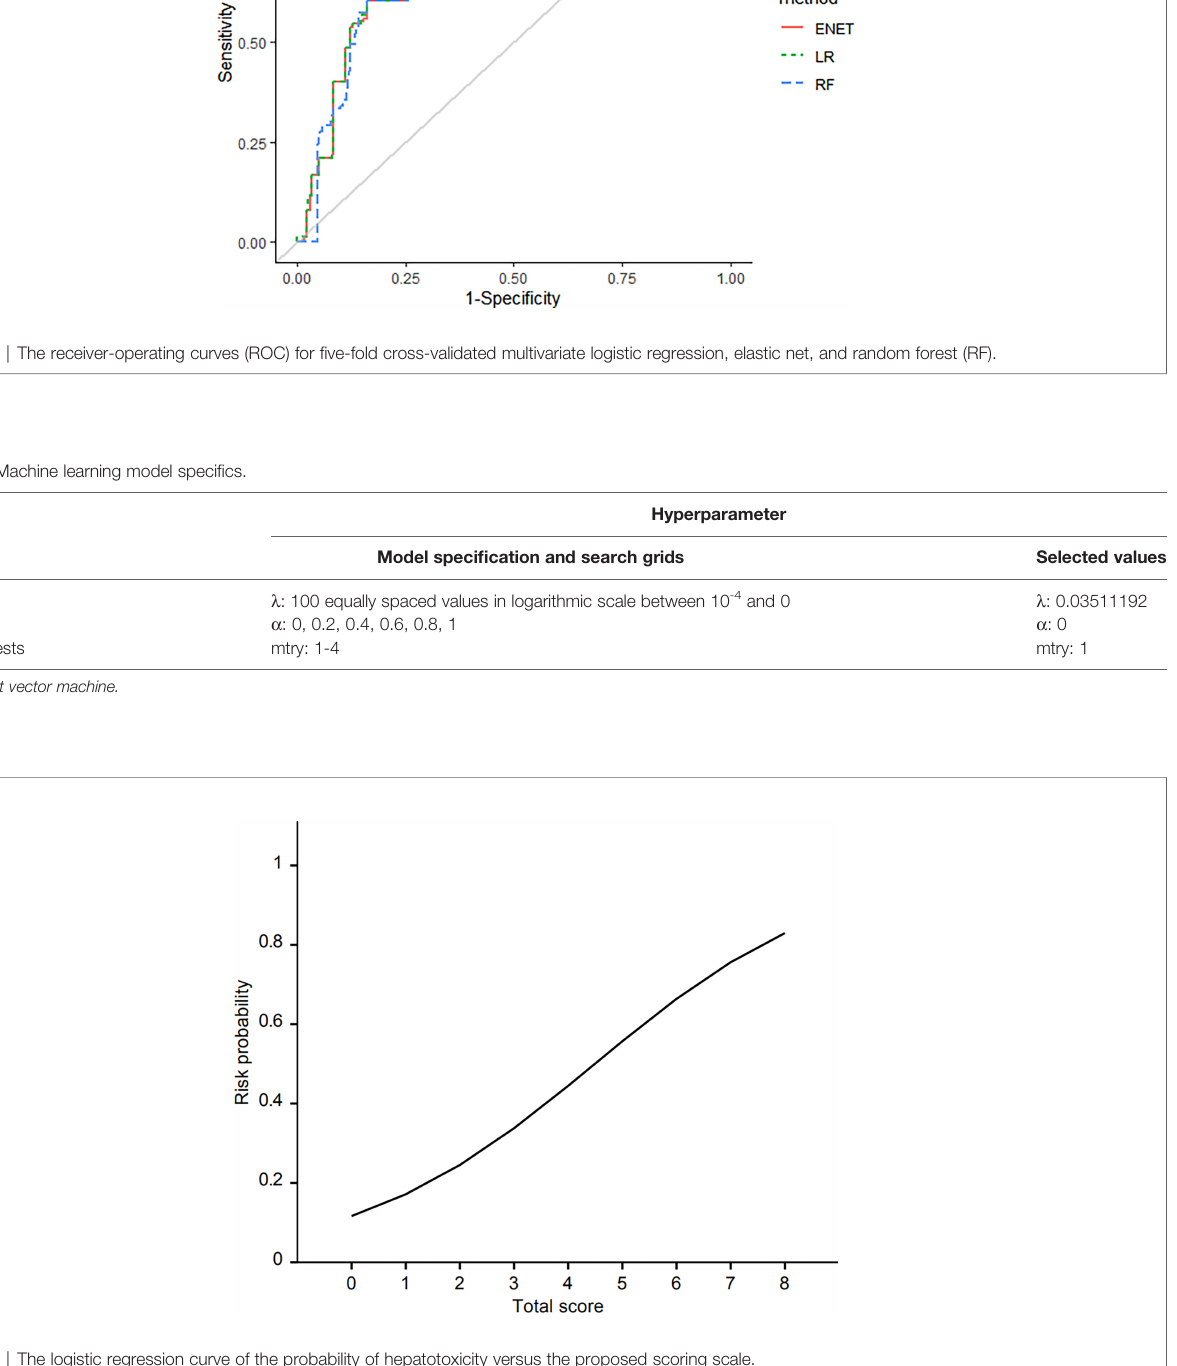
FIGURE 2 | The logistic regression curve of the probability of hepatotoxicity versus the proposed scoring